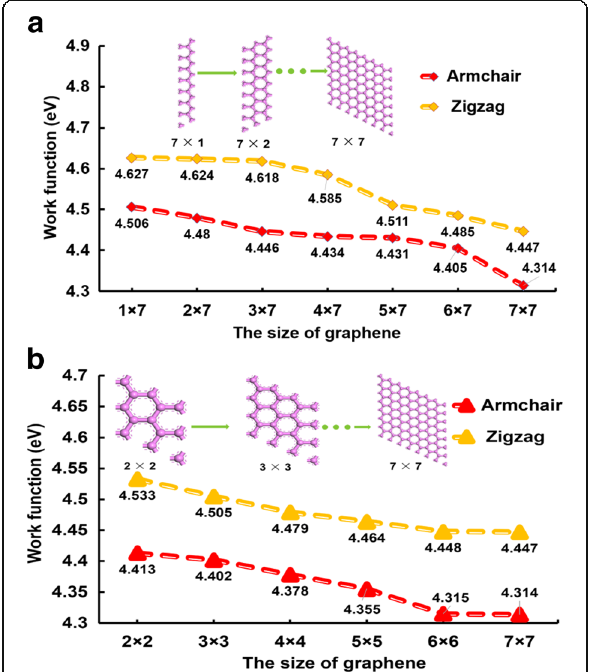
Fig. 2 The relationship between graphene size and WF. The relationship between graphene size and WF. The length and width of graphenes are different in ( a ), whereas the same in ( b )